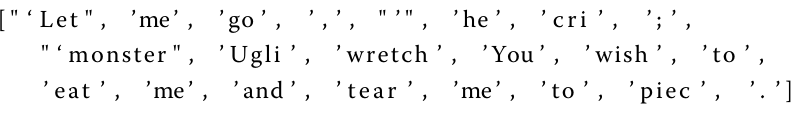
sequence. If there is any token not found in the token frequency dictionary, a zero value is assigned to the